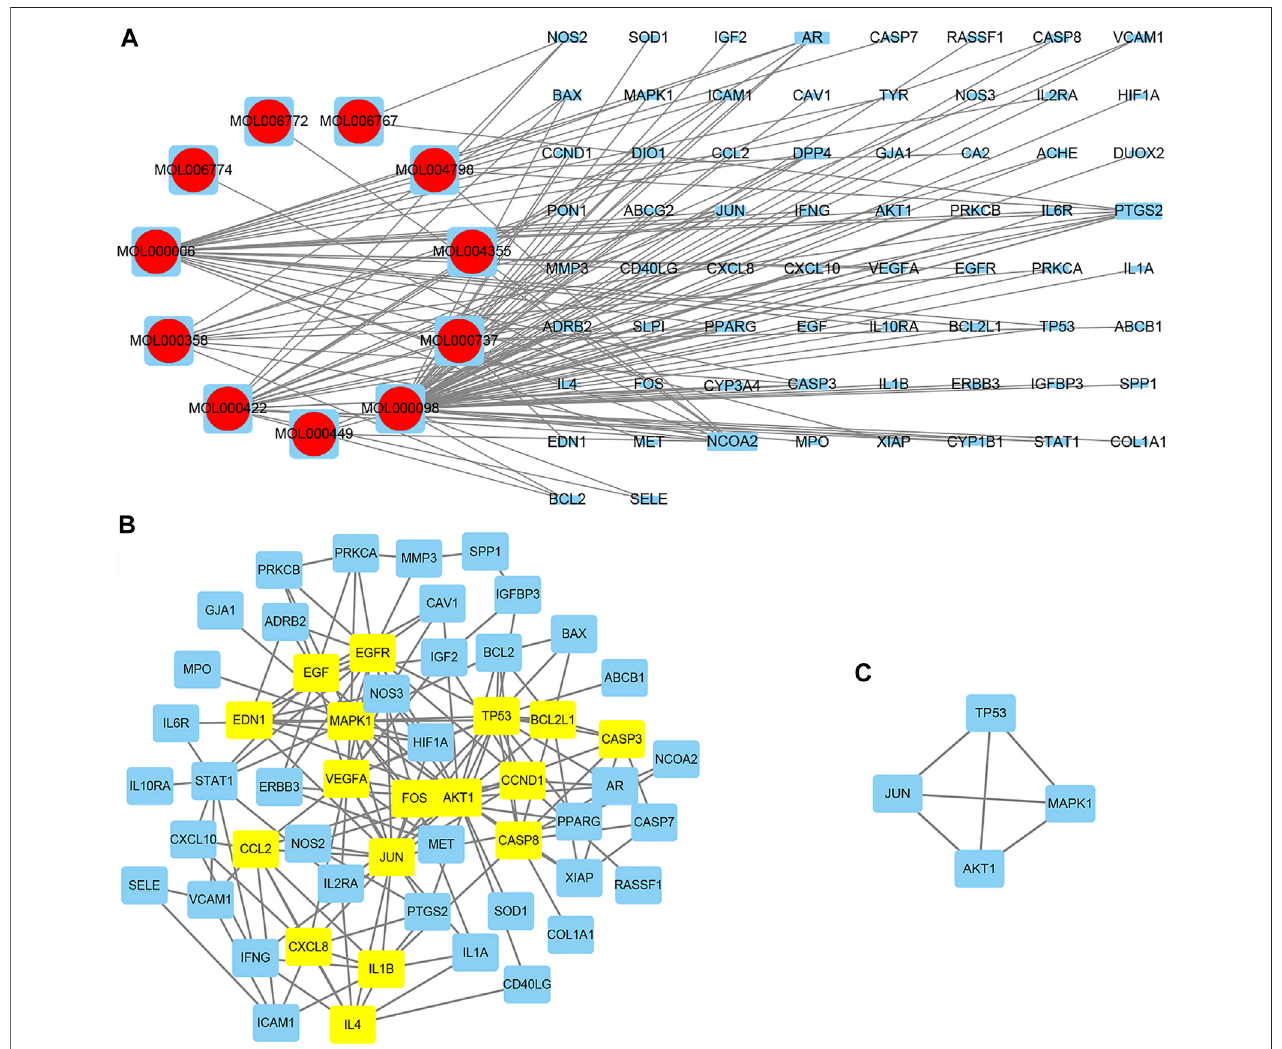
FIGURE 3 | The herb – compound – target